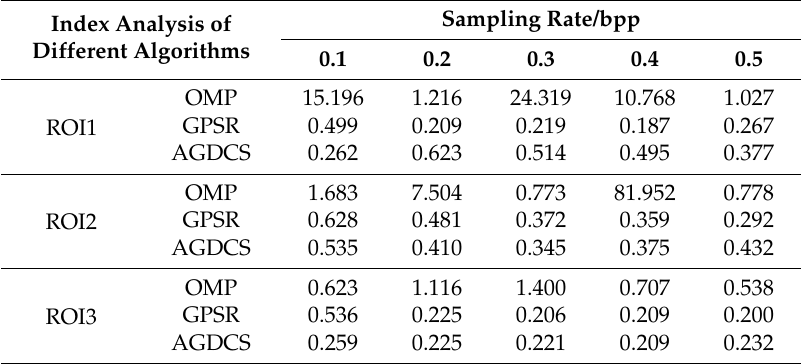
Table 3. RMSE comparison of spectral indices of CRI550.